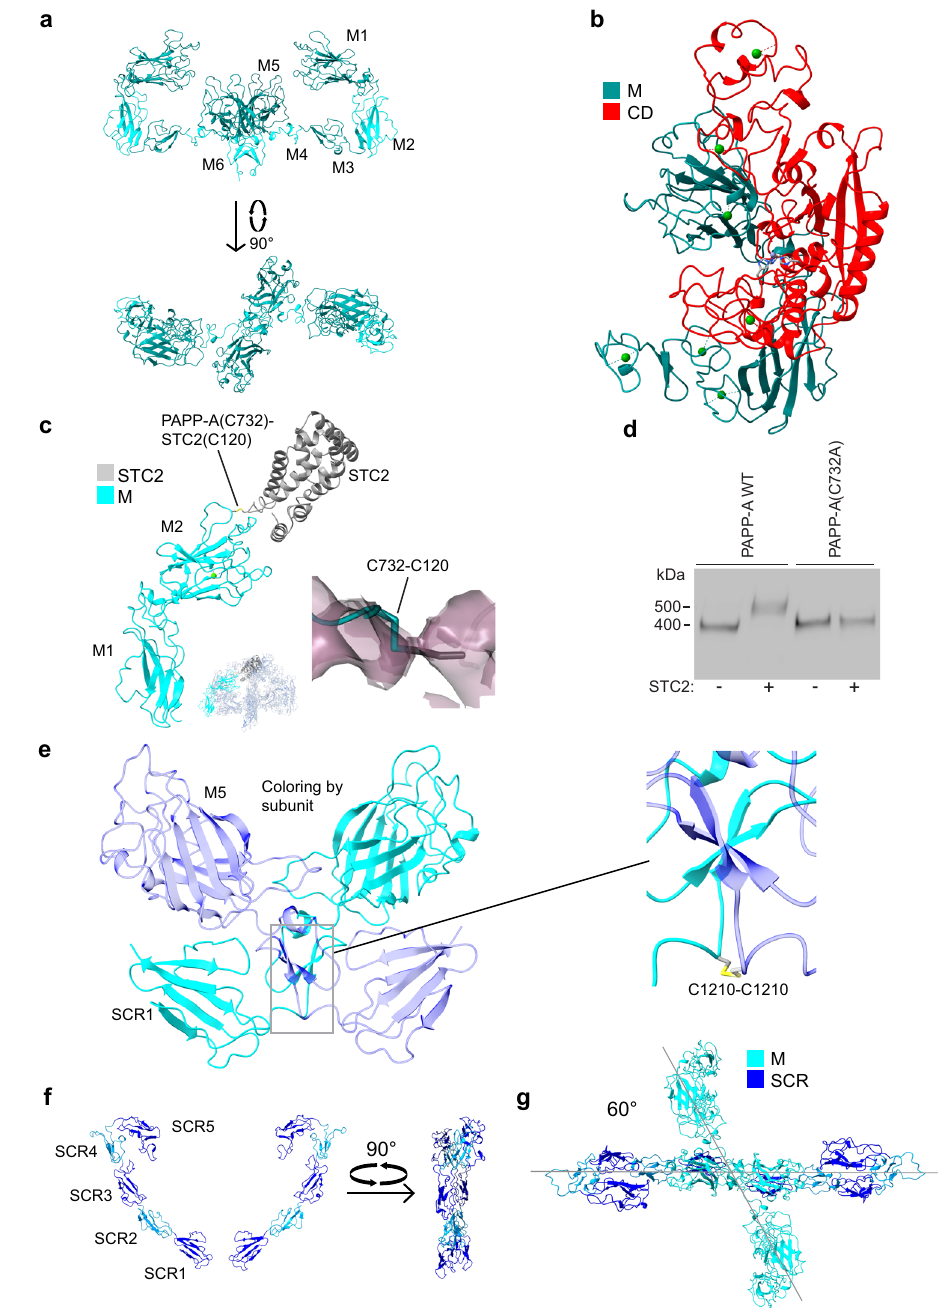
Fig. 5 | Domains of the M region form a scaffold for the structure and lie in a plane with a dihedral angle of ~60° relative to the plane of the SCR domains. a Cartoon representation of the isolated M domains of the 2:2 PAPP-A·STC2 com- plex. The positions of the domains (M1 through M6) are indicated, and domain boundaries are shown by alternating shades of cyan. b Cartoon representation of the CD (red, active site cleft facing left) and domains M1-4 (cyan), showing the positionsofinter-strandloopsofM2relativetotheactivesitecleftwithinthePAPP- A·STC2 complex. c Cartoon representation showing the M1 and M2 domains, one STC2subunit,andthedisul fi debondbetweenC732ofM2andC120ofSTC2,which is responsible for covalent linkage between PAPP-A and STC2. Inset shows map around the C120-C732 disul fi de bond. The map (MAP1) was contoured at 2.0 σ . d Assessment of the ability of wild-type PAPP-A and PAPP-A(C732) to form a covalent complex with STC2. After incubation (16h), the separately synthesized proteins were subjected to non-reducing SDS-PAGE and visualized by Western blottingforPAPP-A.ThePAPP-A(C732)variantisunabletoformthecovalentPAPP-